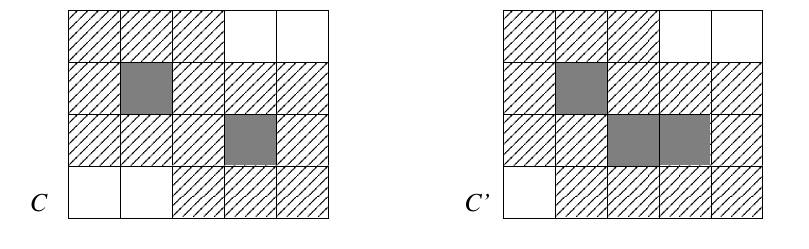
Fig. 3: The effect of changes in Lemma